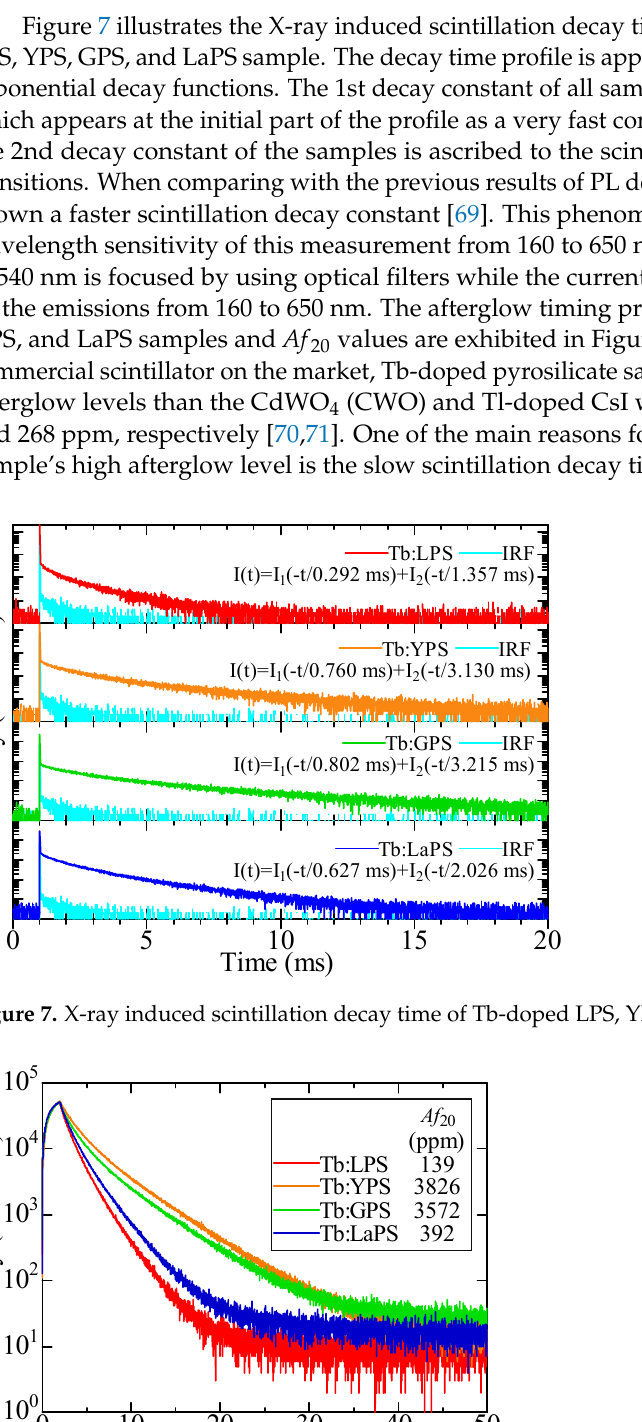
Figure 6. X-ray induced scintillation spectra of Tb-doped LPS, YPS, GPS, and LaPS samples.